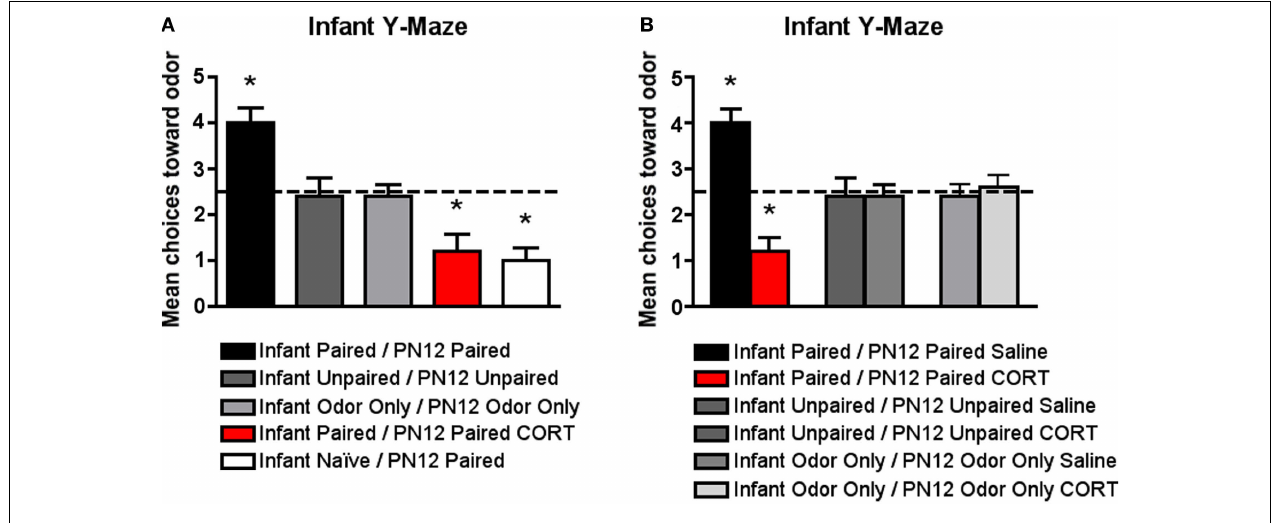
FIGURE 3 | Pups were conditioned daily from PN8 to PN12 (replicates PN13 test data in Figure 2) or conditioned only on PN12 (Infant